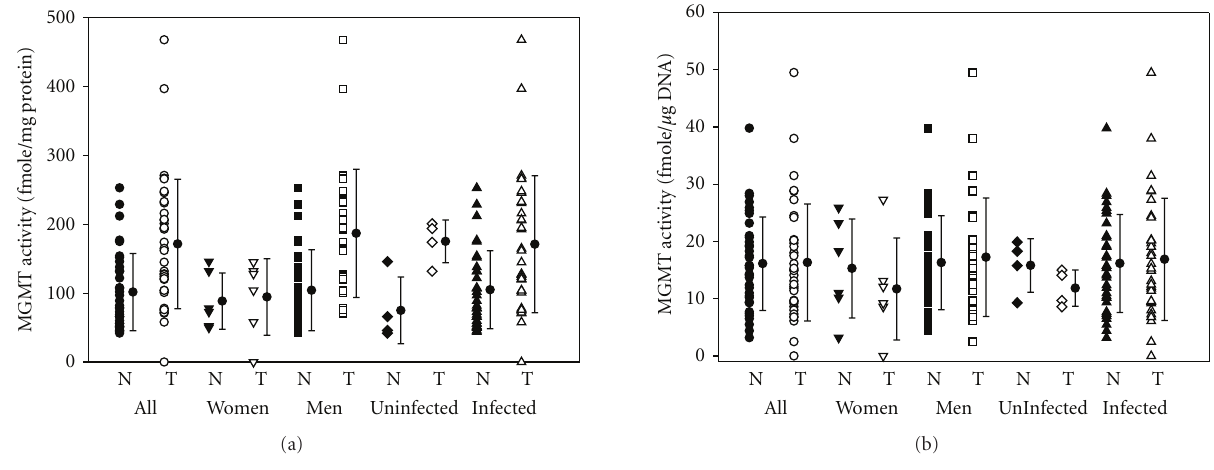
Figure 1: Relationships between MGMT activity (upper: fmole/mg protein, lower: fmole/ug DNA) in normal (N) and tumour (T) tissues of Egyptian bladder cancer patients. Data are also subdivided according to gender and bilharzia status. Statistical analyses are presented in